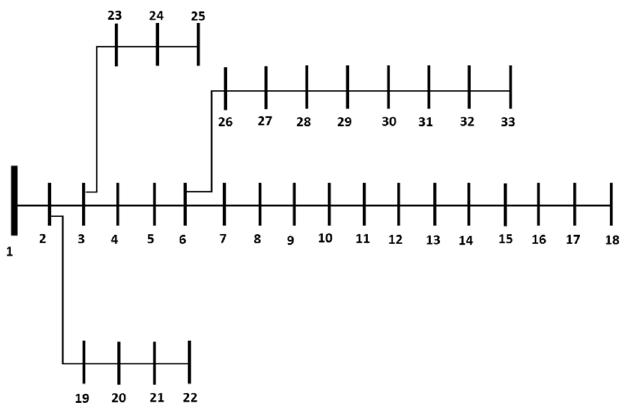
Figure 5. IEEE 33 buses distribution test system, used to simulate and evaluate the effect of the feeder efficiency and the exploited capacity of the DN.